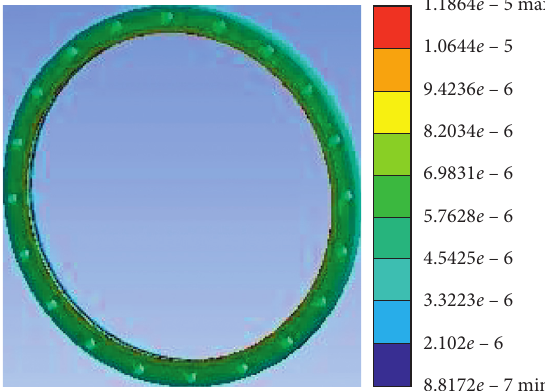
Figure 12: Equivalent stress cloud diagram of the flange.